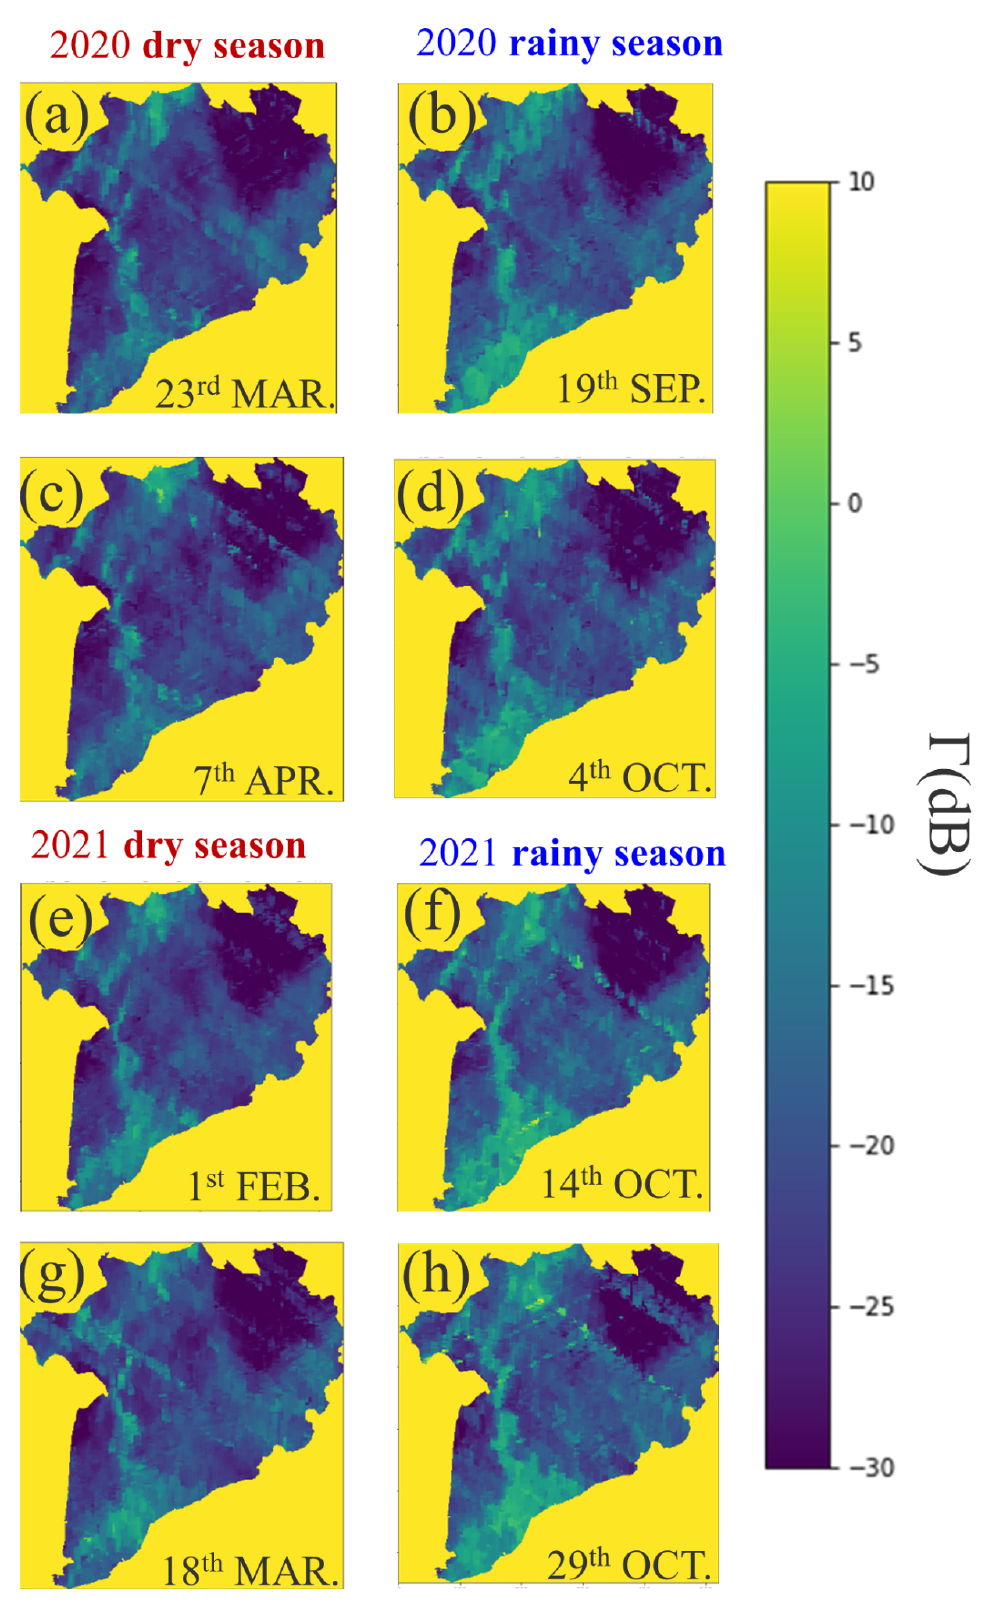
Figure 7. Samples of nonnormalized Γ values in 2020 ( a – d ) and 2021 ( e – h ). The left-hand side scenes are snapshots obtained in dry seasons ( a , c , e , g ). The right-hand side scenes are snapshots obtained in rainy seasons ( b , d , f , h ).